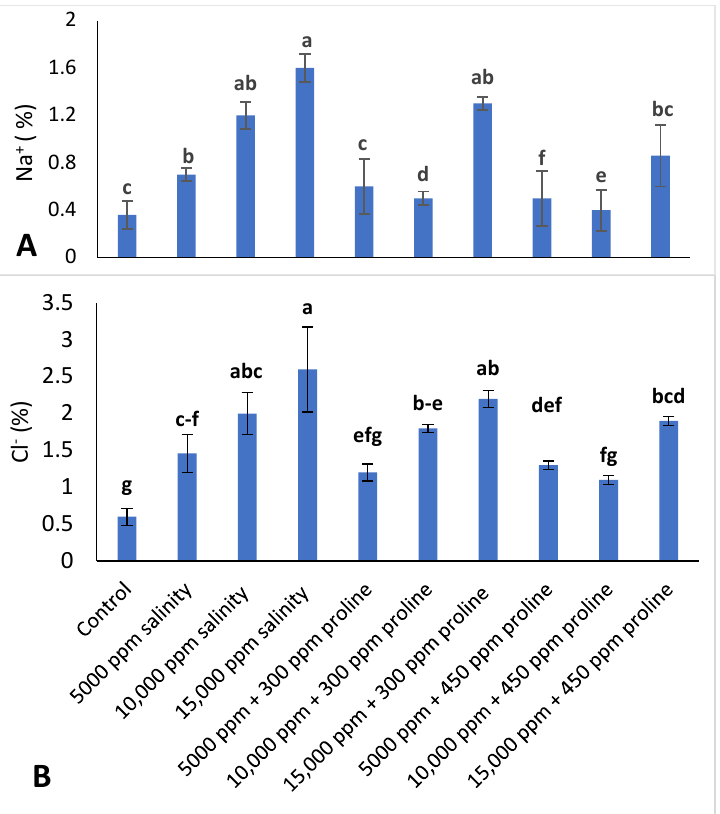
Figure 10. Effect of different levels of seawater salinity and exogenous proline at three concentrations, 0 ppm, 300 ppm, and 450 ppm, on Na + content ( A ) and Cl − content (%) ( B ). Data are means of two seasons (2020 and 2021) and three replicates ( n = 3) each season. The mean values ± SE of each parameter followed by different alphabetical letters are significantly different according to Duncan’s multiple range test at p ≤ 0.05.